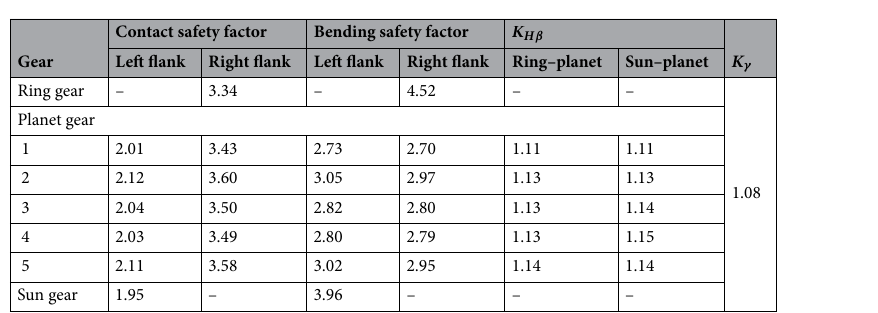
Figure 7. Contact patterns of the gear mesh of planet gear 2 in the flexible pin model with and without lead modifications: ( a ) ring–planet (right flank) without modification, ( b ) sun–planet (left flank) without modification, ( c ) ring–planet (right flank) with slope modification, ( d ) Sun–planet (left flank) with slope modification, ( e ) ring–planet (right flank) with slope modification and crowning, and ( f ) sun–planet (left flank) with slope modification and crowning.